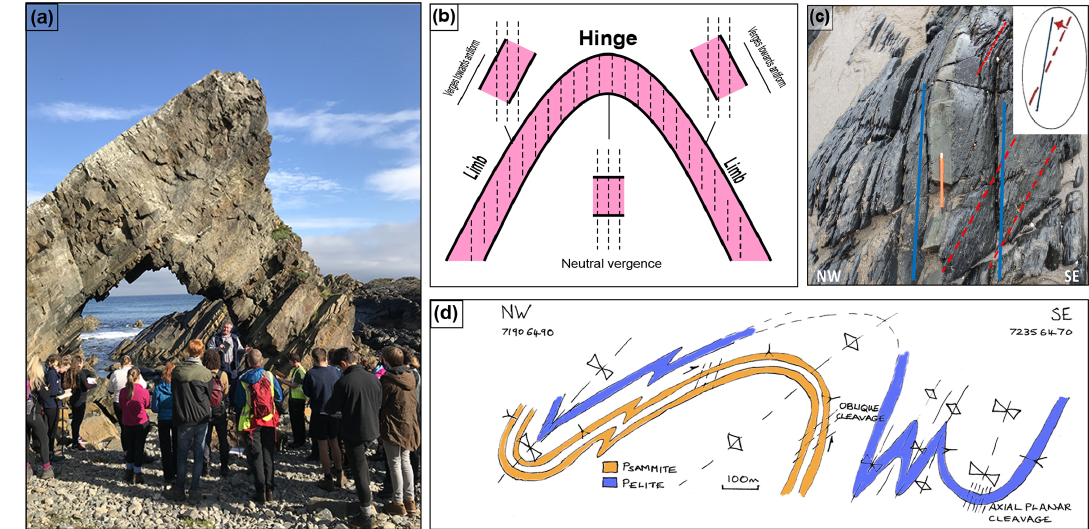
Figure 2. Summary images of a day’s field exercise to map folds in Dalradian metasediments and to use the concept of cleavage vergence to create a cross section. (a) Example student group being shown bedding–cleavage relationships in the field and how they can be used to predict an anticline of syncline along section. (b) Classroom-based course material showing cleavage–bedding relationships around a fold; the students employ this concept in the field to build a cross section. (c) Example from a field photograph of a bedding–cleavage relationship and interpretation and (d) worked solution cross section. Note that the course material and worked solutions were developed by Ian Alsop, Clare Bond and Rob